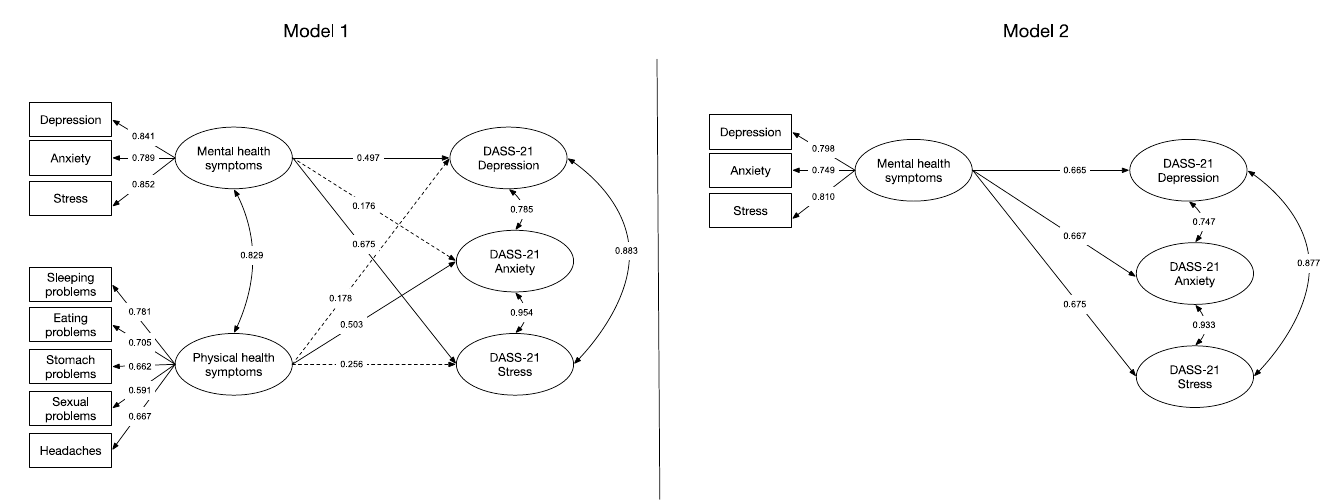
Figure 2. Model comparison of the associations between the scale of mental and physical health symptoms and DASS ‐ 21.